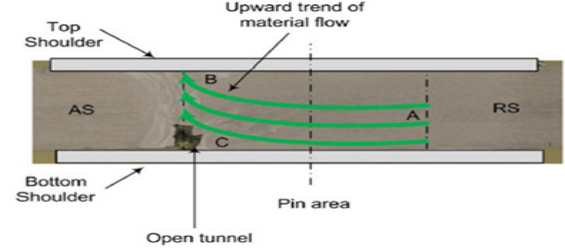
Fig. 6. Material motion around threaded probe.